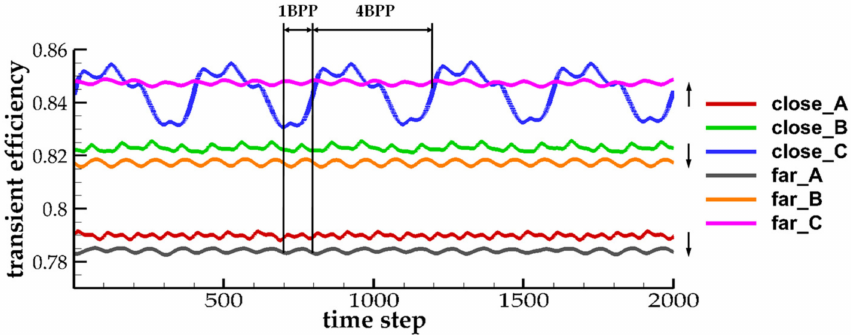
Figure 7. Transient efficiency of the research